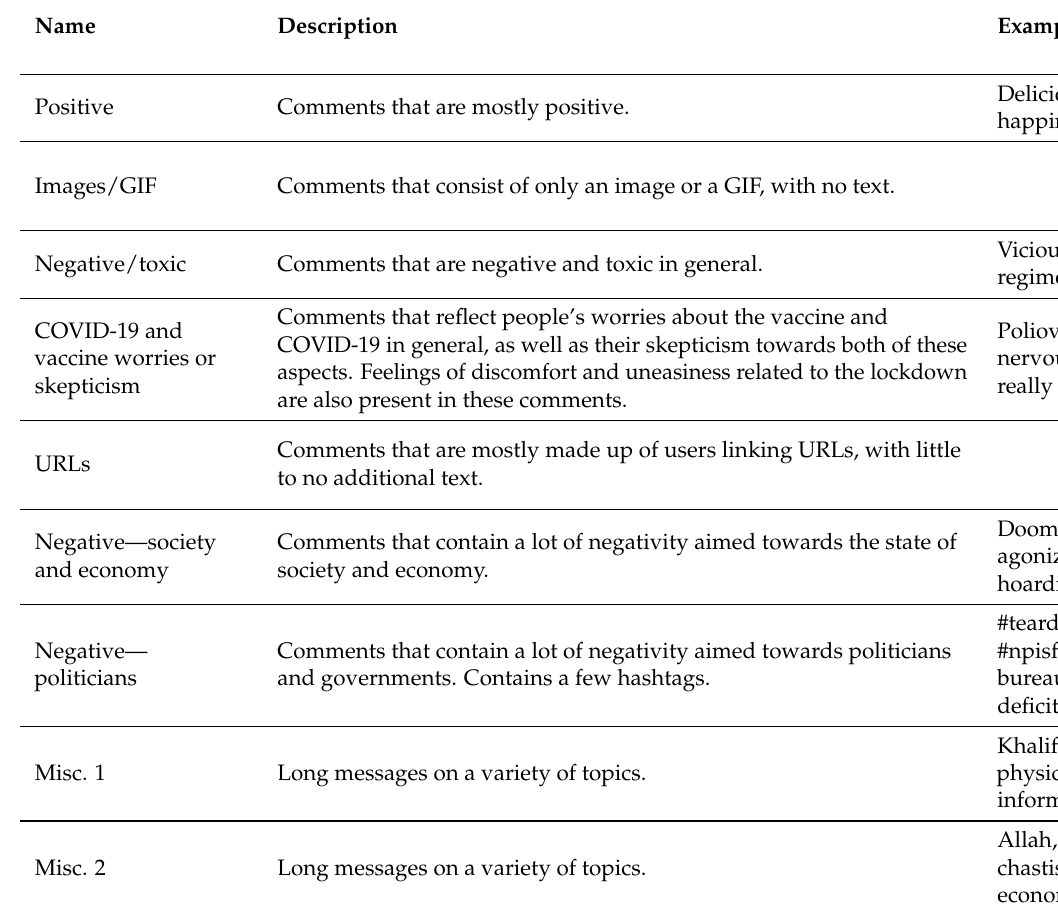
Table 3. Description of the 9 hidden states, with examples of their most meaningful unigrams and